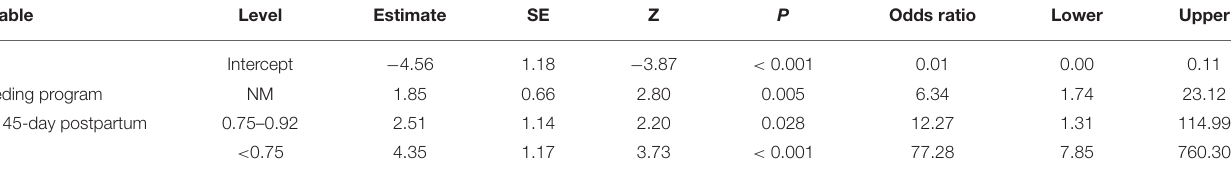
Multivariate model